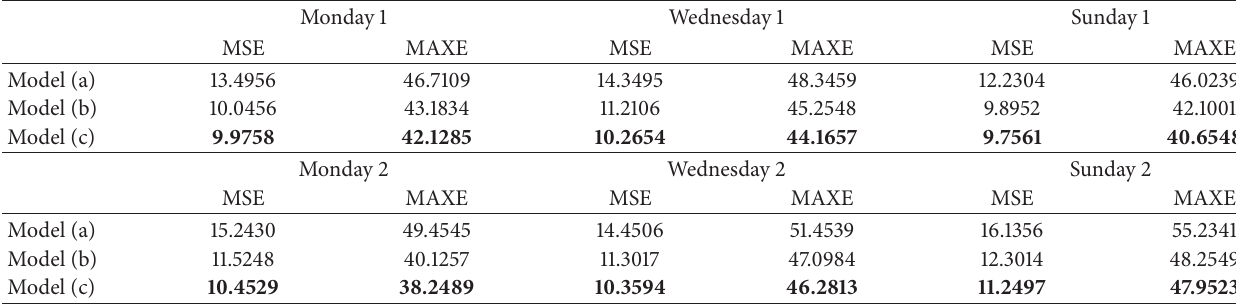
Table 3: The comparison of 3 different